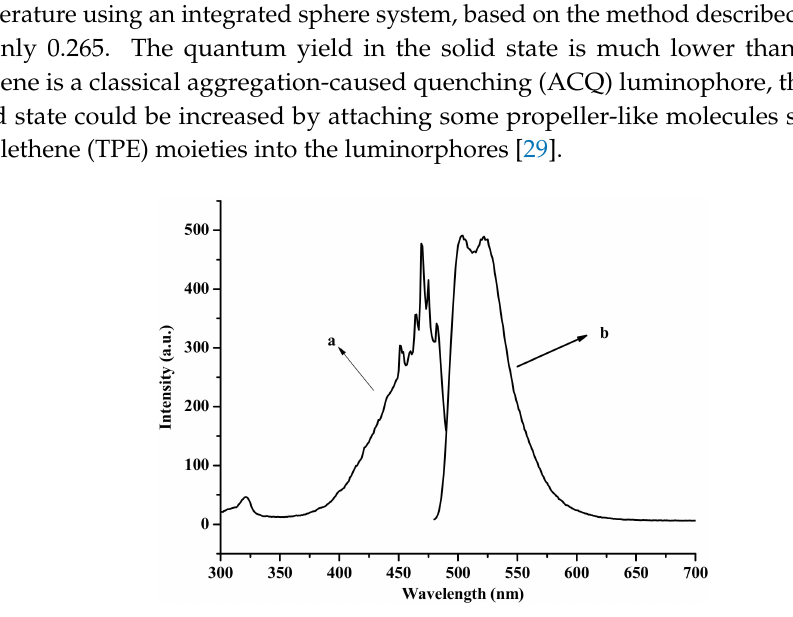
Figure 3. Excitation ( a : λ em = 503 nm) and emission spectra ( b : λ ex = 469 nm) of BPEA in CH 2 Cl 2 (3.66 × 10 − 6 mol / L).